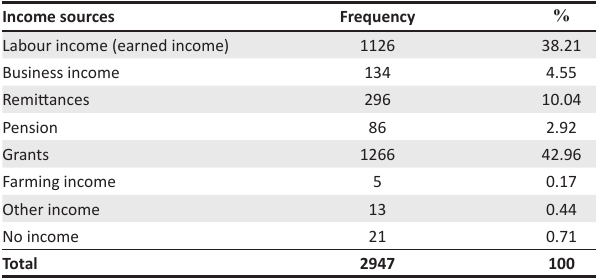
TABLE 2: Income sources. Income sources Frequency